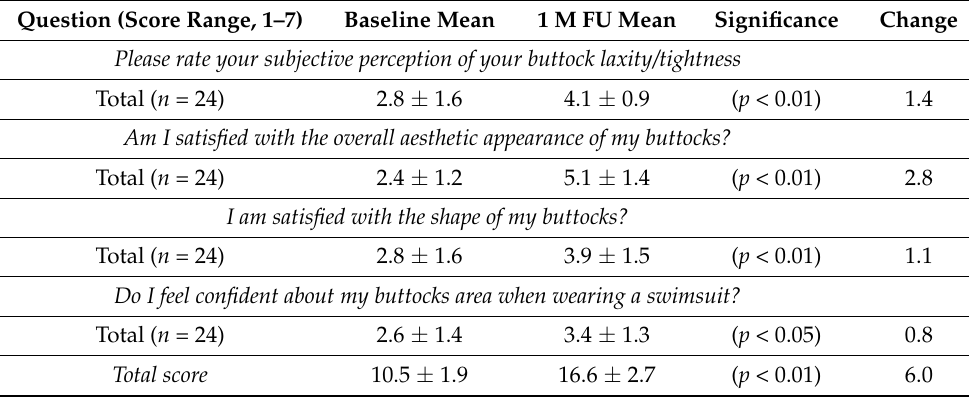
Table 1. Buttock satisfaction questionnaire results.